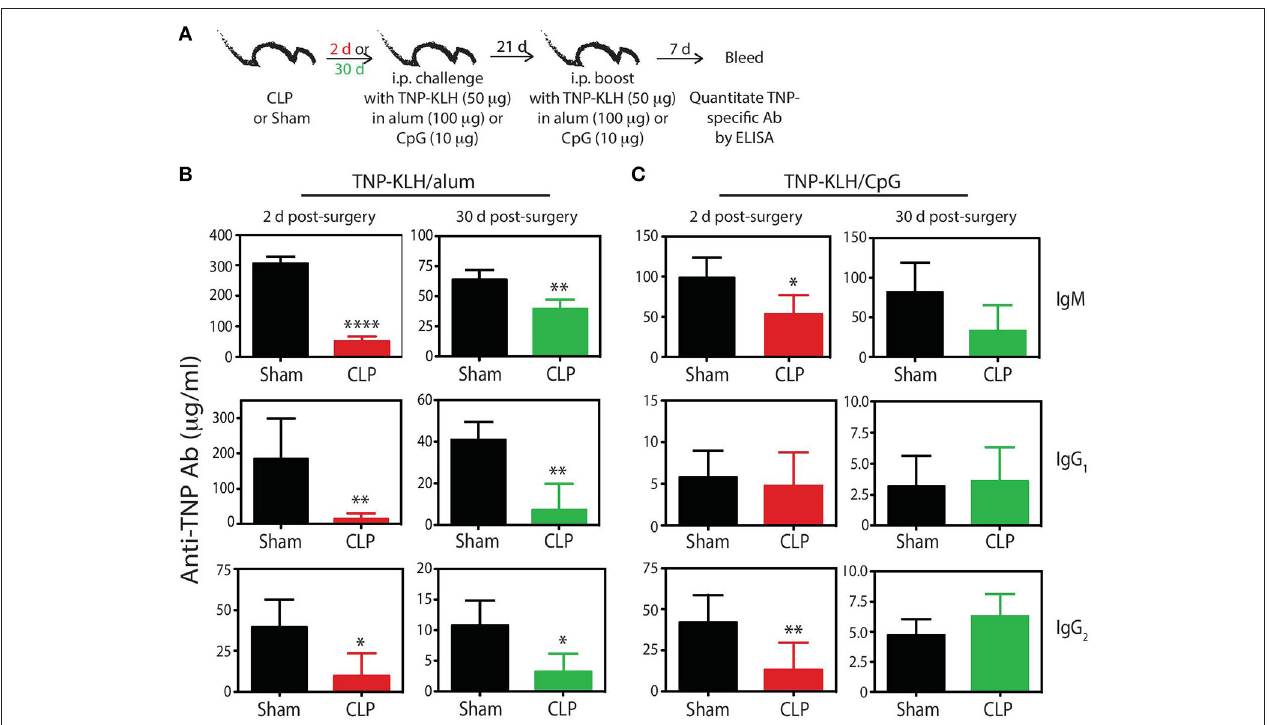
FIGURE 7 | Generation of anti-TNP mAb is reduced in septic mice . (A) Experimental design—B6 mice were immunized i.p. with 50 µ g TNP-KLH in alum or CpG 2 or 30 days after sham or CLP surgery. A second immunization was administered 21 days later. Blood was collected for serum 7 days after the second immunization. Serum concentrations (quantified via ELISA) of anti-TNP Ab from (B) TNP-KLH/alum- and (C) TNP-KLH/CpG-immunized mice 2 and 30 days after sham and CLP surgeries. n = 4–6 mice/group. * p < 0.05, ** p < 0.01, **** p < 0.001. Data are representative of at least 2 independent